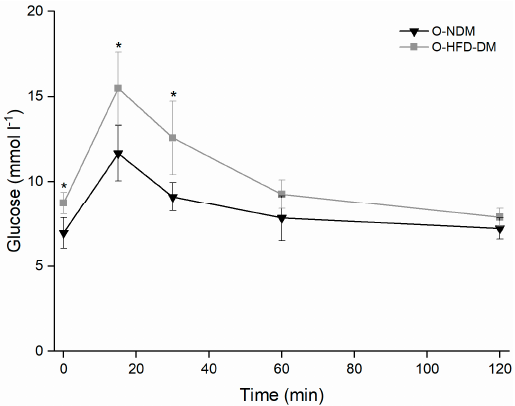
Figure 1. Oral glucose tolerance test measurements of 54-week-old non-diabetic mice ( ▼ ) ( n = 9) and 54-week-old high-fat diet-induced diabetic mice ( ■ ) ( n = 9). Data are means and standard de- viation (SD); * p < 0.05 vs. O-NMD